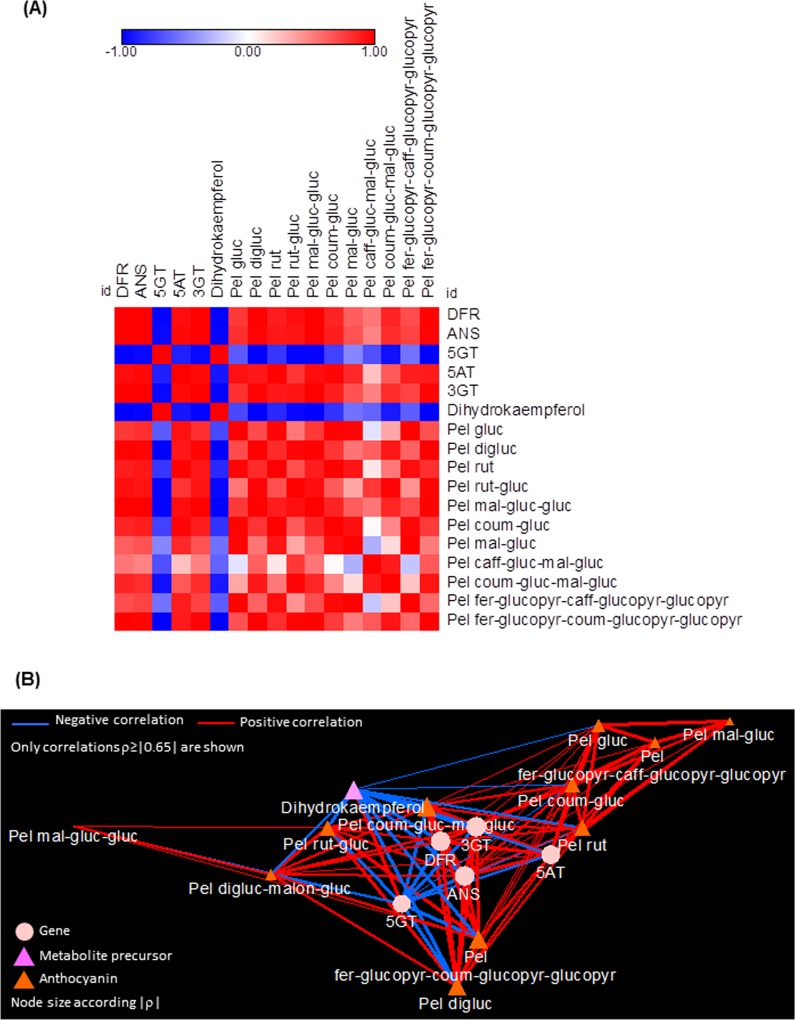
Integration of transcript-metabolite data involved in G. lutea L. var. aurantiaca anthocyanin metabolism.(A) Pearson coefficient-based correlation matrix. Legend on the right corresponds to the names of the anthocyanin transcripts and metabolites. Red and blue shaded boxes represent different levels of positive and negative correlations, respectively; white boxes represent no correlation. (B) Anthocyanin transcript/metabolite correlation network using a prefuse force-directed layout (only ρ > 0.65 are shown). Transcripts, anthocyanins and anthocyanin precursors are represented, respectively, as pink rounds, and orange and violet triangles. Blue and red edges refer to negative and positive correlations, respectively. Node size is according to the node strength (ns, representing the average of all the ρs of each node). Lines joining the nodes indicate positive (red) and negative (blue) correlations, of width proportional to each corresponding |ρ|. Abbreviations: ANS, anthocyanidin synthase; 5AT, anthocyanin 5-aromatic acyltransferase; DFR, dihydroflavonol 4-reductase; 3GT, UDP-glucose:flavonoid 3-O-glucosyltransferase gene; 5GT, UDP-glucose:flavonoid 5-O-glucosyltransferase; Pel coum-gluc, Pelargonidin 3-O-(6-p-coumaroyl)glucoside; Pel digluc, Pelargonidin 3,5-O-diglucoside; Pel caff-gluc-mal-gluc, Pelargonidin 3-O-(6-O-caffeoyl-D-glucoside)-5-O-(6-O-malonyl-β-D-glucoside); Pel fer-glucopyr-caff-glucopyr-glucopyr, Pelargonidin 3-O-[2-O-(6-(E)-feruloyl-β-D-glucopyranosyl)-6-O-(E)-caffeoyl-β-D-glucopyranoside]-5-O-(β-D-glucopyranoside); Pel fer-glucopyr-coum-glucopyr-glucopyr, Pelargonidin 3-O-[2-O-(6-(E)-feruloyl-β-D-glucopyranosyl)-6-O-(E)-p-coumaroyl-β-D-glucopyranoside]-5-O-(β-D-glucopyranoside); Pel gluc, Pelargonidin 3-O-glucoside; Pel mal-gluc, Pelargonidin 3-O-(6-O-malonyl-β-D-glucoside); Pel rut, Pelargonidin 3-O-rutinoside; Pel rut-gluc, Pelargonidin 3-O-rutinoside-5-O-β-D-glucoside; Pel mal-gluc-gluc, Pelargonidin 3-O-(6-O-malonyl-β-D-glucoside)-5-β-D-glucoside; Pel coum-gluc-mal-gluc, Pelargonidin 3-O-(6-p-coumaroyl-D-glucoside)-5-(4-O-malonyl-β-D-glucoside).